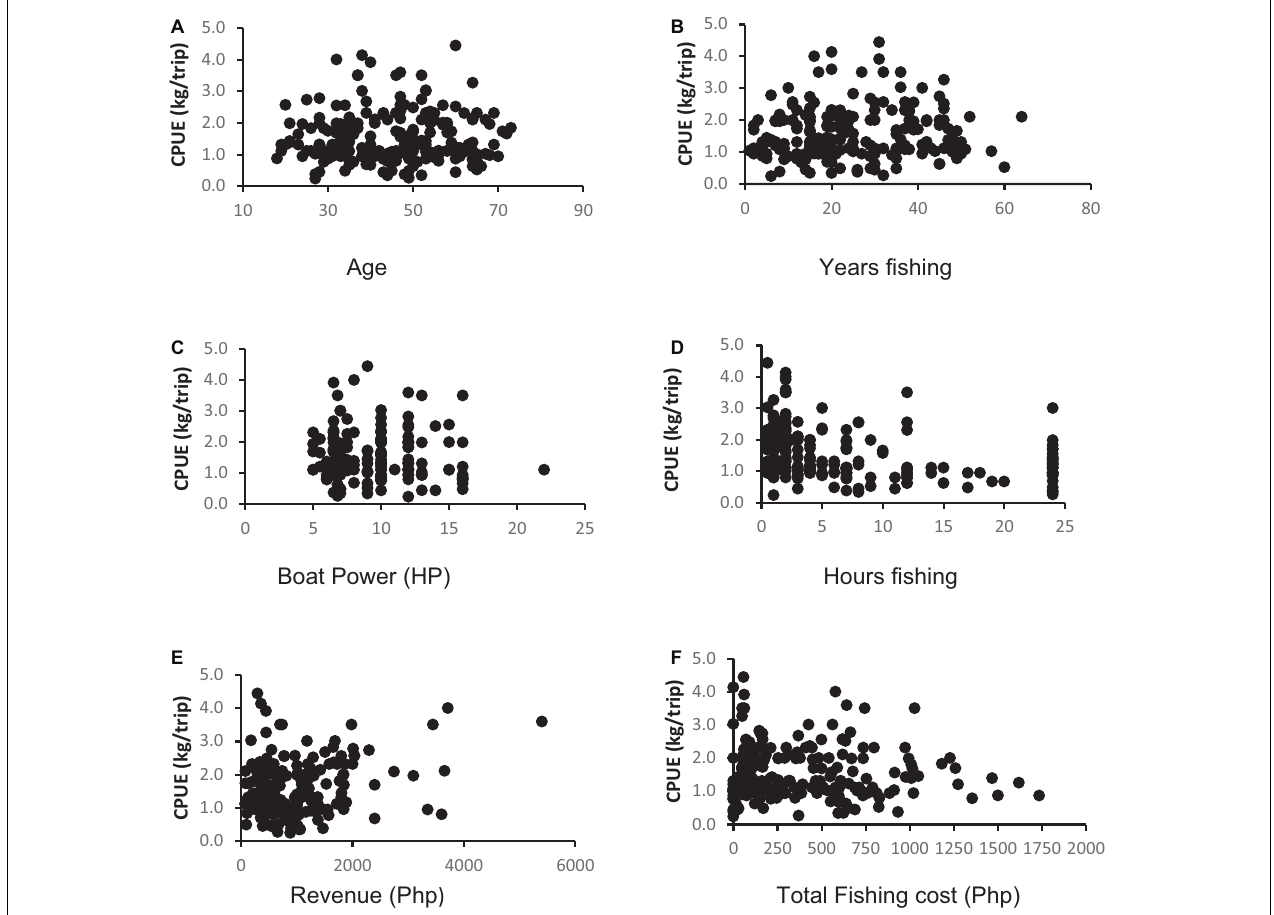
FIGURE 2 | CPUE per trip based on the regression model and the modeled data from the survey. The age and number of years of fishing show that the data is bell-shaped, thick at the center and tapered at both ends (A,B) with ages between 40 and 60 showing that they can have higher cpues while the number of years fishing show that longer fishing experience may not matter. While for the boat power and the number of hours fishing (C,D) a horse power of 6 can get as much as those on 12 and 16 and fishing longer hours do not yield more fish. The revenue and fishing costs are skewed to the left, showing that most of the trips yield on average a revenue of Php 1,000.00 at an average fishing cost of Php 400.00 (E,F)